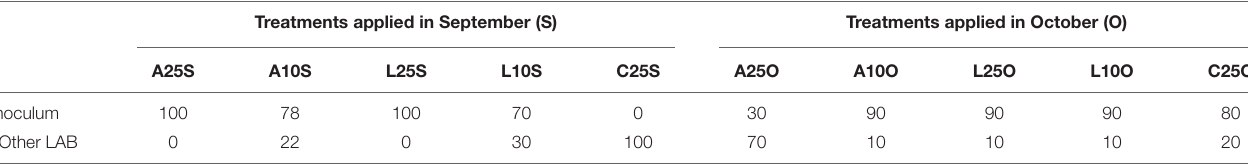
TABLE 1 | Predominance (expressed as percentage) of the inoculated Lactobacillus pentosus LAB2 strain at the moment of maximum LAB population in the diverse treatments assayed. Treatments applied in September (S) Treatments applied in October